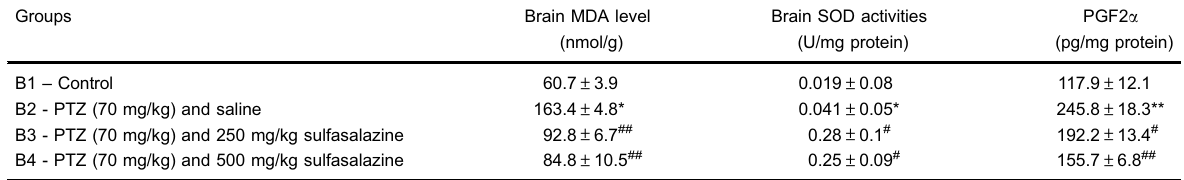
Table 3. Improvement in brain malondialdehyde (MDA) level, superoxide dismutase (SOD) activity, and prostaglandin F2 a (PGF2 a ). Groups